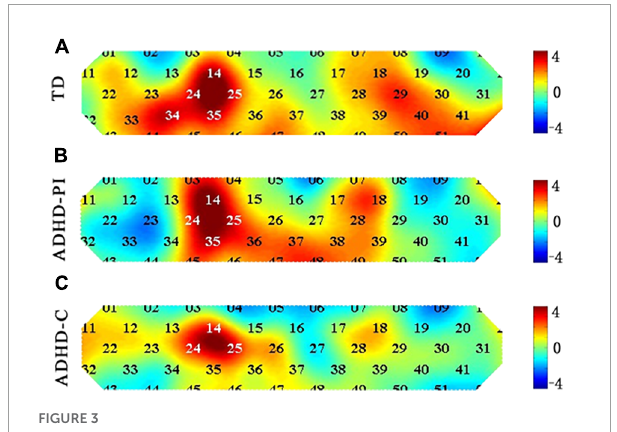
FIGURE3 Heat map of t -values comparing the activation of TD children (A) and those with ADHD-PI (B) and ADHD-C (C) during response inhibition (Go/No-go block minus Go block) for 52 channels. The 52 channels are colored by their t values according to the color scale. As shown in the color scale on the right, warm colors represent positive t -values, and cool colors represent negative t -values. A dark color indicates a large absolute t -value.